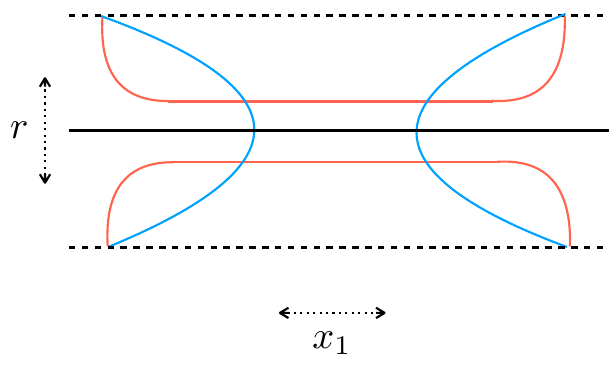
Figure 5 . Illustration of the di(cid:11)erent entangling surfaces in the thermo(cid:12)eld double. The whole setup is taken at t = 0. The dotted horizontal lines represent the two boundaries, and the solid black line in the middle represents the black brane horizon. The entangling surface consists of two identical pieces, one in each boundary. The red entangling surface is similar to two copies of what one would have in the one-sided black hole, while the blue one goes through the